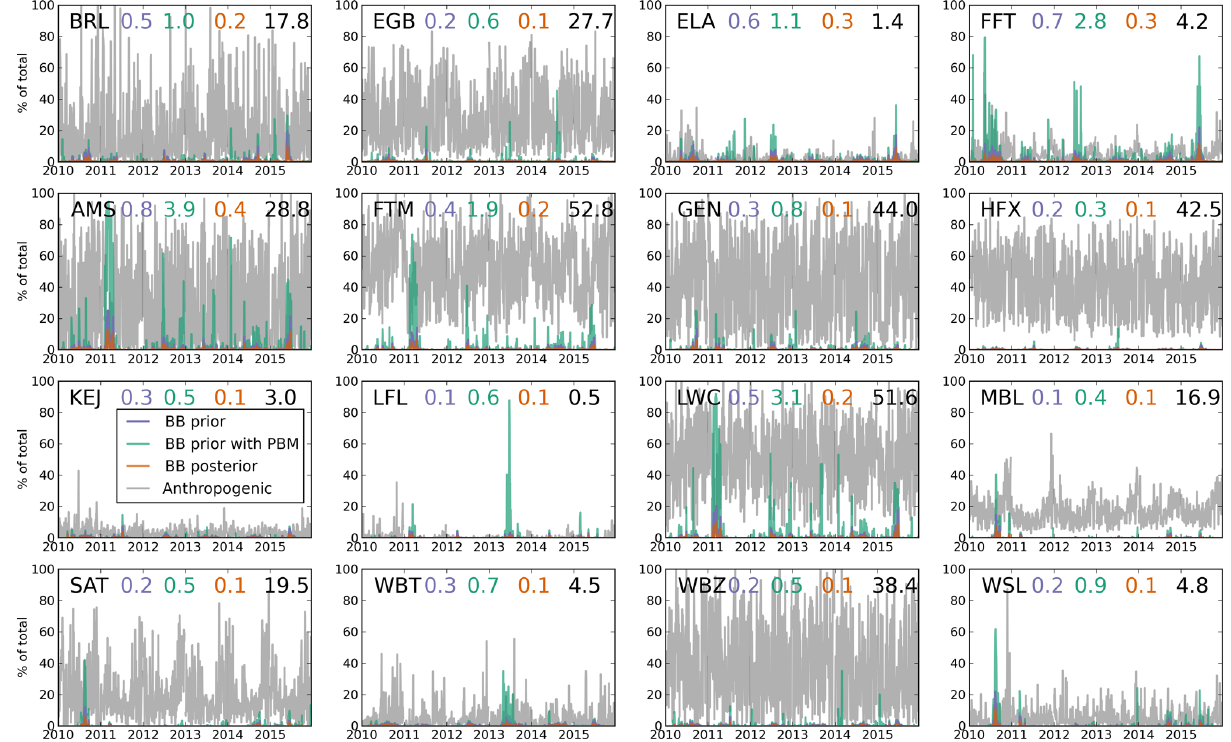
Figure 12. Same as Fig. 10, but for the Canadian observation